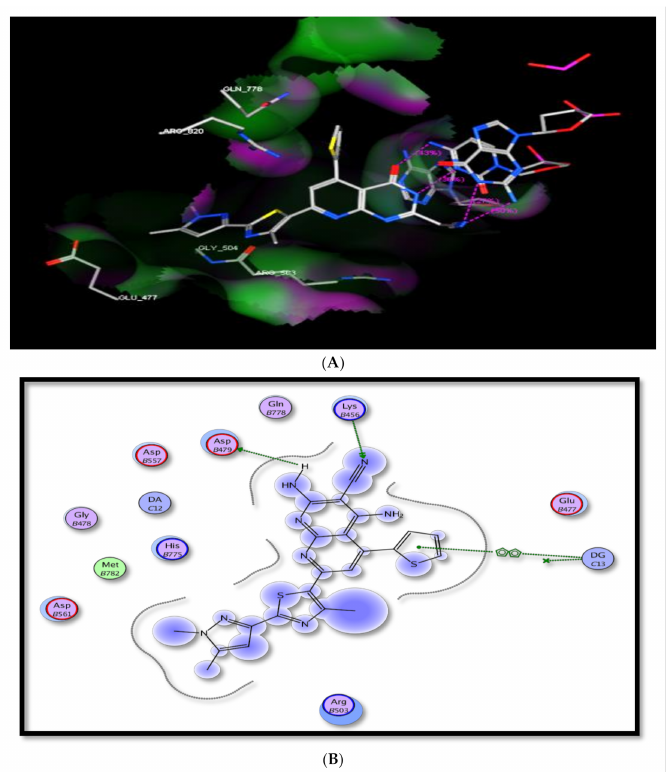
Figure 4. The suggested binding mode of compound 6 within topoisomerase II. ( A ) 3D binding mode within the active site. ( B ) 2D binding mode within topoisomerase II.